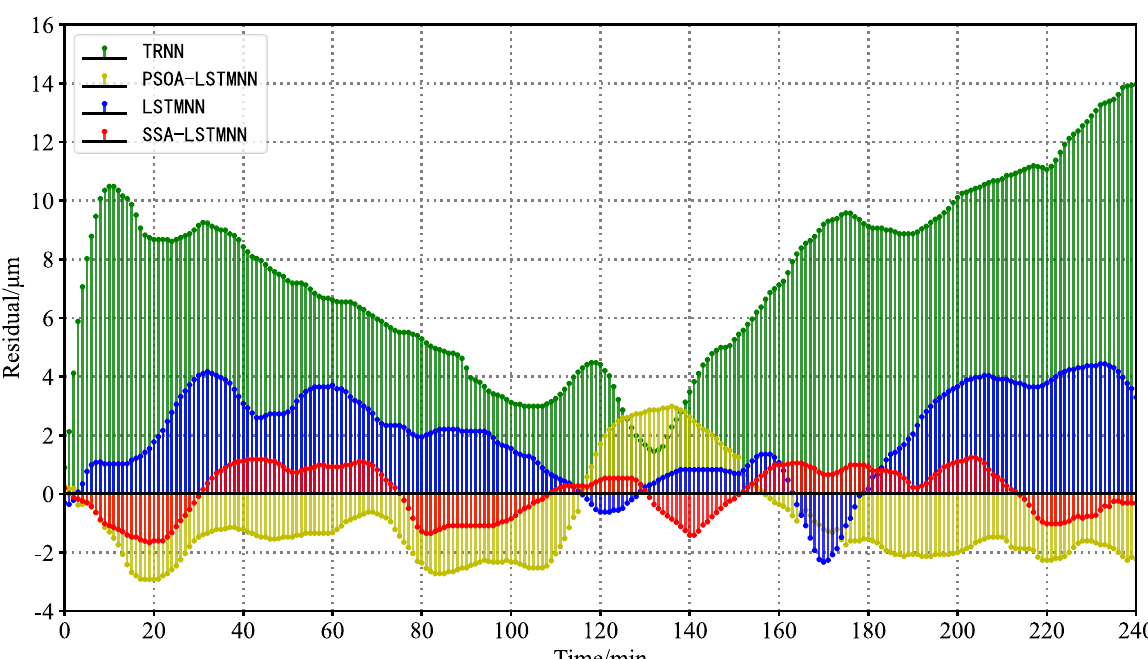
Figure 20. Residual curves for each model at velocity V 2 = 5000 mm/min.